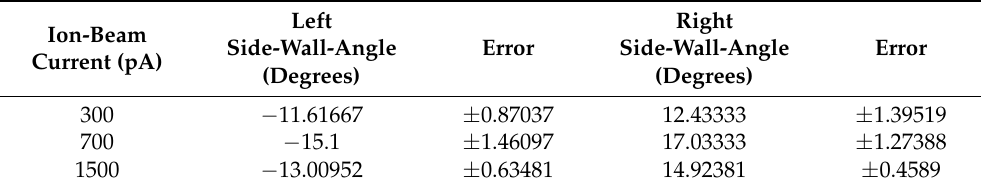
Table 1. The structural profiles of the fabricated PhC elements measured in terms of left and right wall angles at ion-beam currents of 300, 700 and 1500 pA.